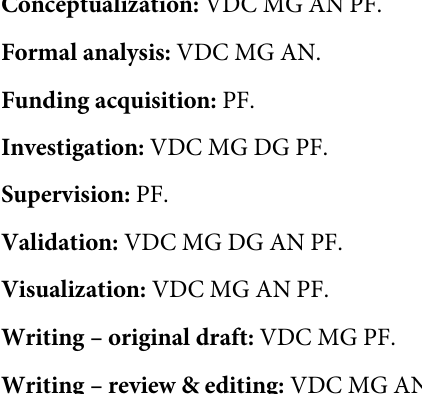
S4 Table. List of accession numbers of the Lokiarchaeal and Thorarchaeal proteins included in the concatenation-based analyses. S5 Table. List of the species sampled for the different phylogenetic analyses in this study. S6 Table. Number of ESPs located in the different sets of contigs suggested from the genome quality